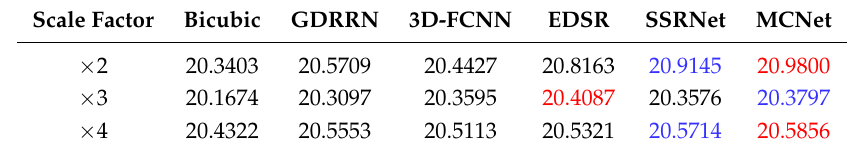
Table 5. No-reference image quality assessment of state-of-the-art SR algorithms by average NIQE for different scale factors. The red and blue indicate the best and second performance, respectively.